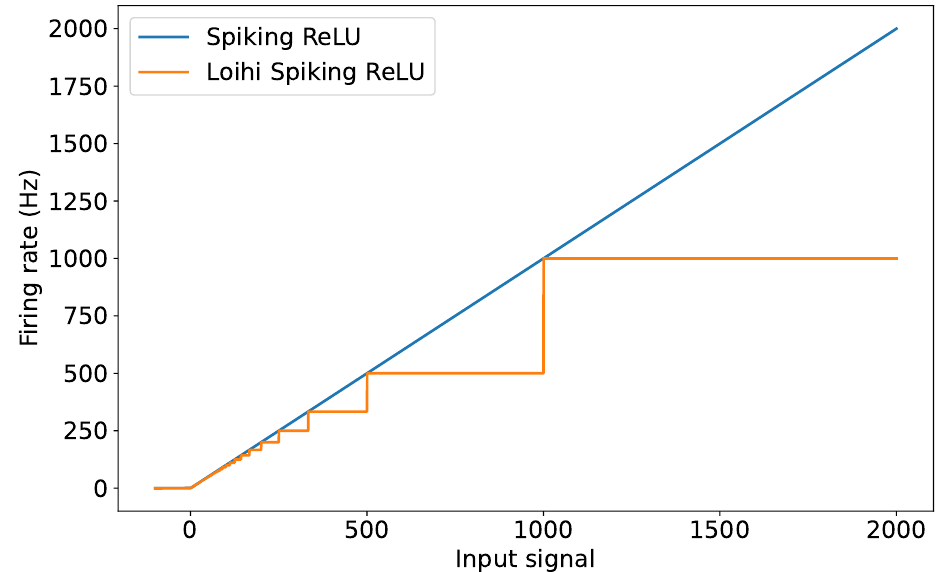
Figure 1. Spiking ReLU activation profile (based on DeWolf et al.